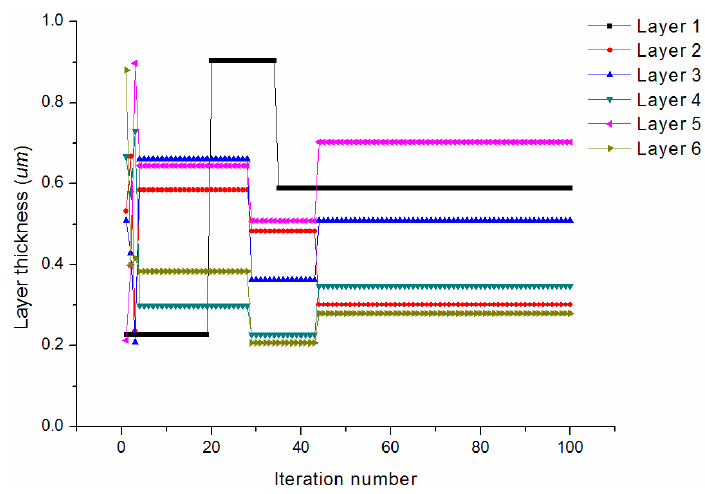
Figure 9. Convergence of the design variables for minimizing the transverse CTE.